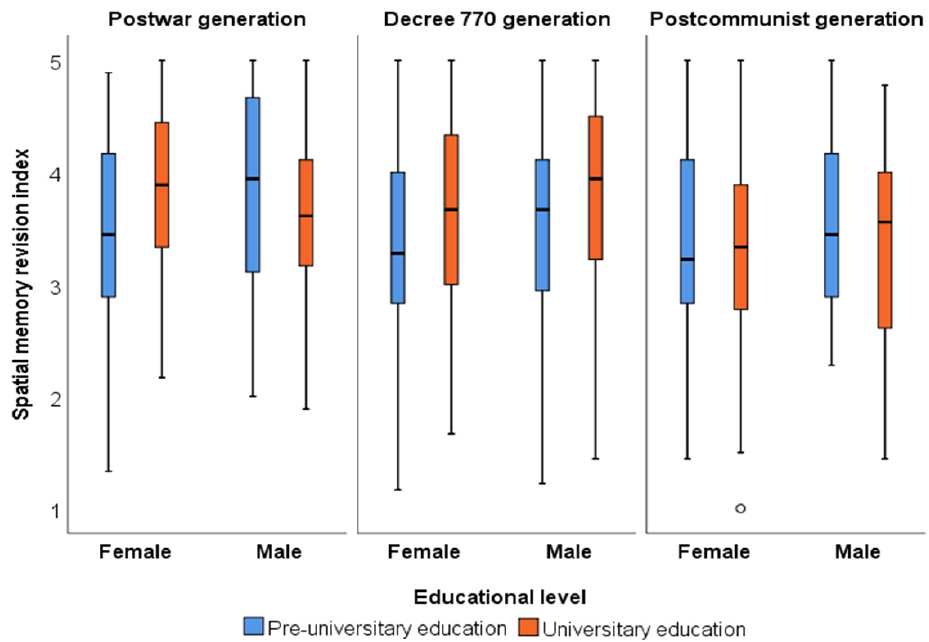
Figure 2. Variation of the spatial memory revision index according to socio-demographic variables.